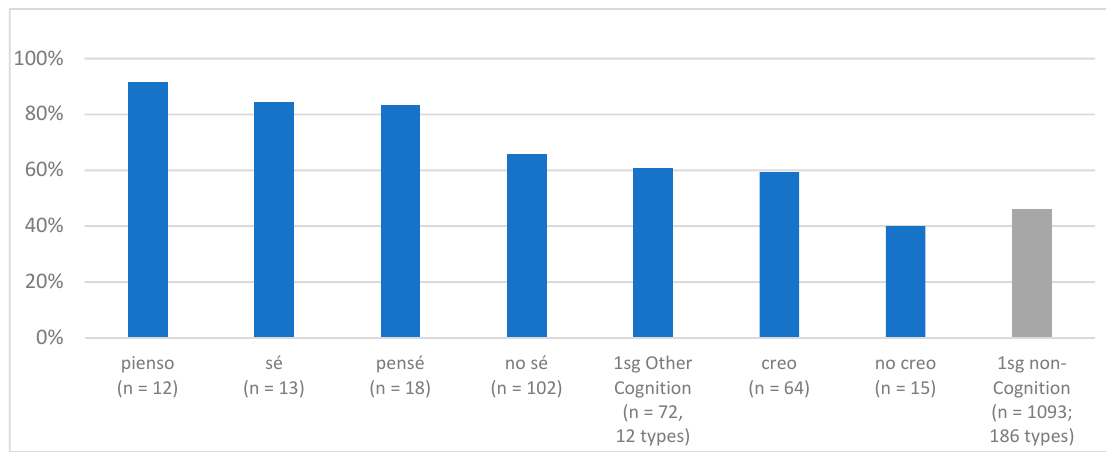
Figure 4. Rates of expression for verbs w. 1sg subjects (forms with > 10 tokens). The favoring of subject pronouns generally holds across all cognition verb items; subject expression rates vary for individual lexical types according to particular constructions.